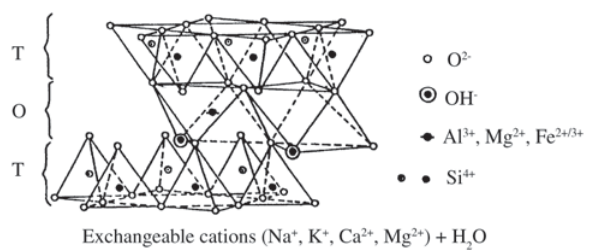
Figure 1. Montmorillonite structure. T: tetrahedral sheet; O: octa- hedral sheet.